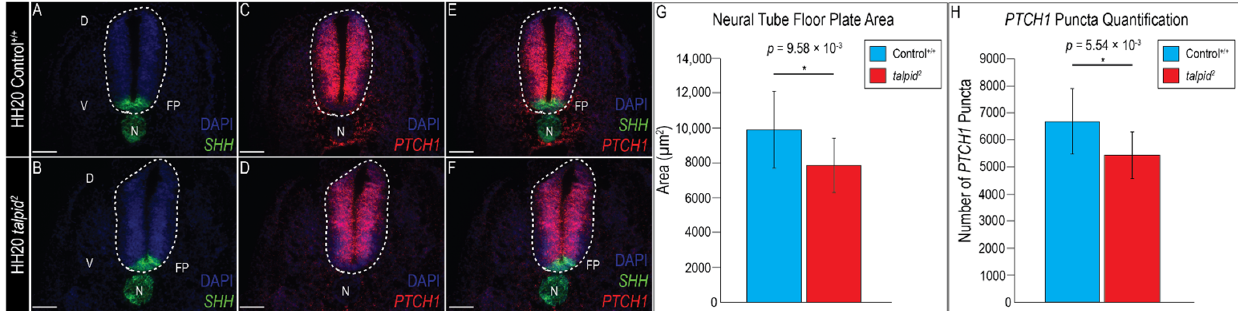
Figure 3. Loss of ventral neural progenitors correlates with decreased PTCH1 expression. ( A – F ) RNAscope in situ hybridization for ( A , B ) SHH , ( C , D ) PTCH1 , or ( E , F ) both SHH and PTCH1 in HH20 control +/+ and ta 2 neural tubes. ( G ) Quantification of floor plate area in HH20 control +/+ and ta 2 neural tubes. ( H ) Puncta quantification for PTCH1 expression in HH20 control +/+ and ta 2 neural tubes. D: dorsal, FP: floor plate, N: notochord, V: ventral. White dotted ovals outline the neural tubes. Scale bars: ( A – F ) 100 μ m. Error bars represent the mean data ± s.d. Statistical analysis was performed utilizing Student’s t -test (* denotes p < 0.05). 3.3. Midfacial Widening in the ta 2 Correlates with Increased PTCH1 Expression in the Frontonasal Prominence Early craniofacial patterning requires an inductive interaction from the brain to the face as SHH from the forebrain induces SHH expression in the ectoderm of the frontonasal prominence (FNP) [75]. SHH expression in the FNP abuts with Fibroblast growth factor 8